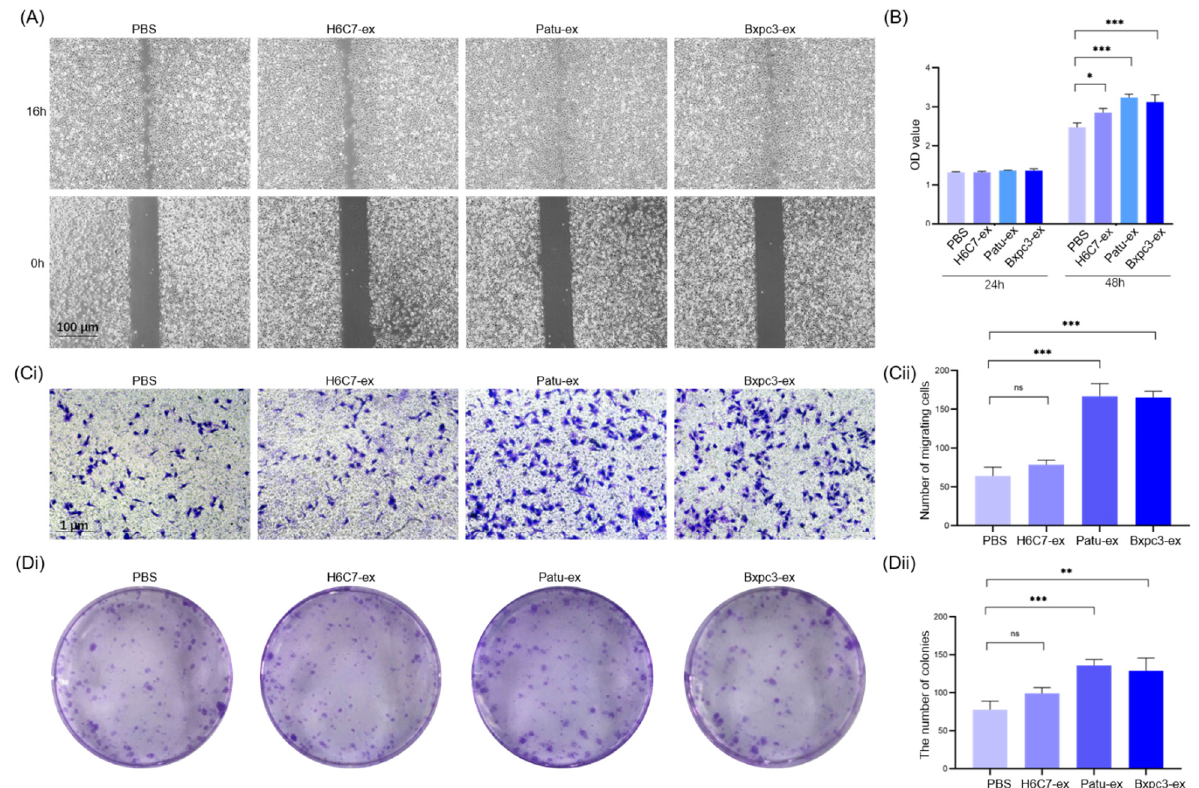
Figure 2. Exosomes from pancreatic cancer cells enhance the proliferation and migration of HLECs. ( A ) Wound healing assay was performed to watch the migration of HLECs in 16 h. ( B ) CCK8 assay was performed to test the viability of HLECs. ( Ci ) Transwell assay was performed to observe the number of transferred cells. Scale bar: 1 μ m, 10×. ( Cii ) Statistical analysis of Transwell assay ( n = 3). ( Di ) A colony formation assay was performed to observe the proliferation of HLECs. ( Dii ) Statistical analysis of the colony-formation assay ( n = 3). * p < 0.05. ** p < 0.01, *** p < 0.001.